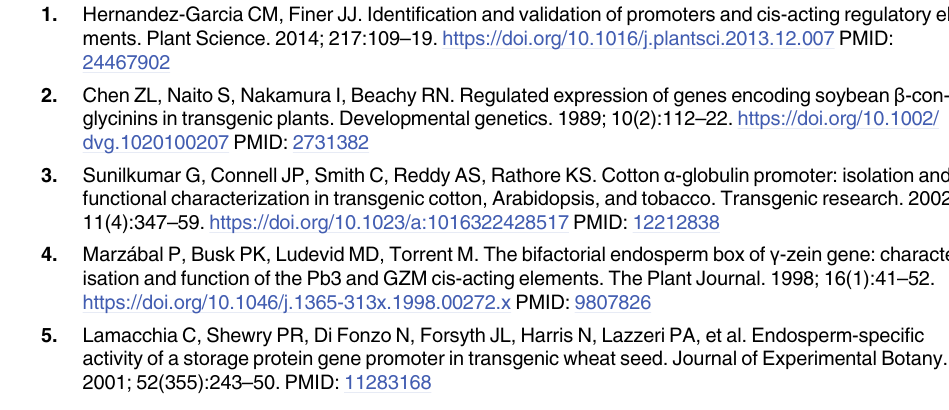
S1 Table. Oligonucleotide sequences used for genomic DNA PCR. S2 Table. Oligonucleotide sequences used in quantitative real-time